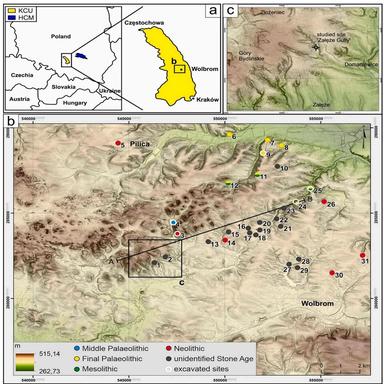
Localization of the studied area. (a) Regions of occurrence of the chocolate flint deposits: Krakow-Cz ´ ęstochowa Upland (KCU, yellow) and Holy Cross Mountains (HCM, blue). (b) The area indicated in (a) with marked Stone Age archaeological sites bearing chocolate flint artefacts (1–31). Frame indicates the Załęze ˙ gully area shown in (c),, and A-B line indicates the line of the geological cross-section shown in. (c) Magnification of the area indicated in (b). (For inter